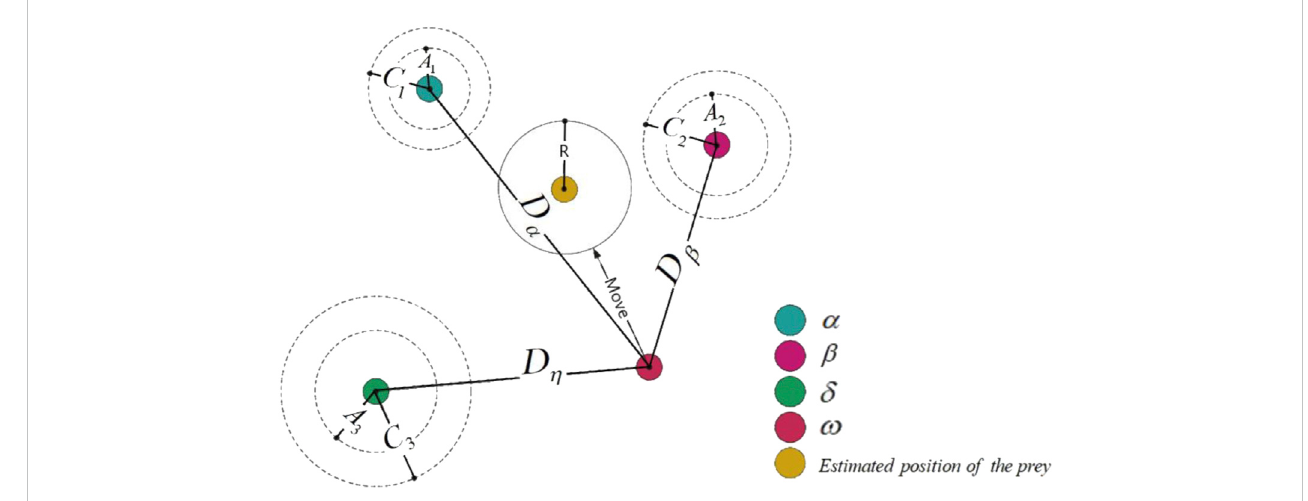
FIGURE 3 Location updating process of grey wolves in 2D space.